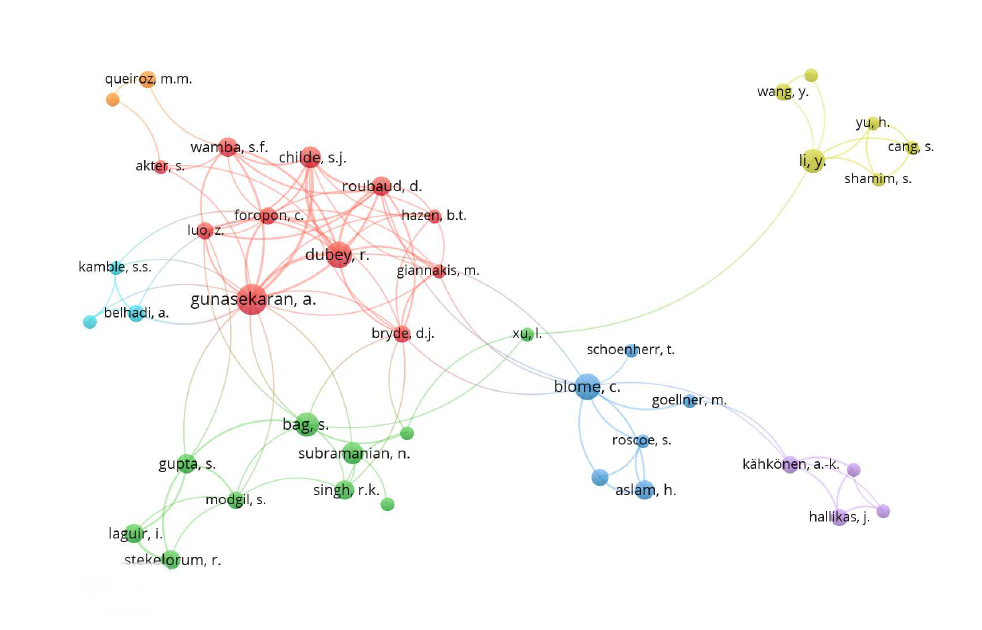
Figure 5. Cluster of authors in Scopus